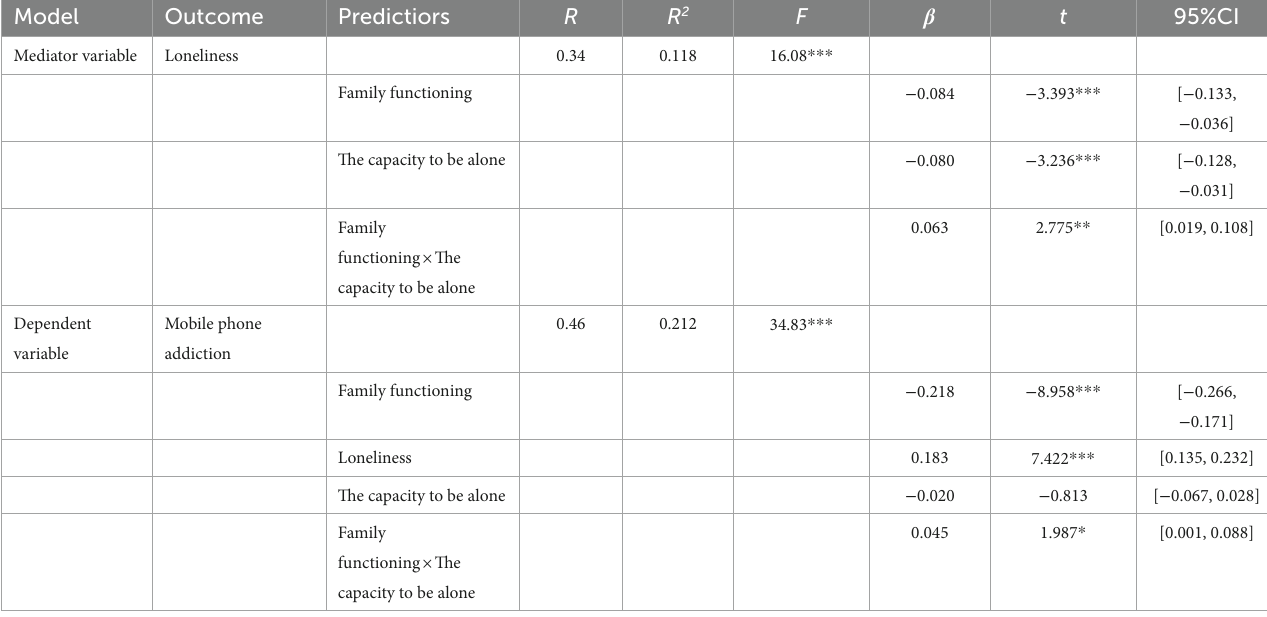
TABLE 3 Testing for the moderated mediation effect. Model Mediator variable